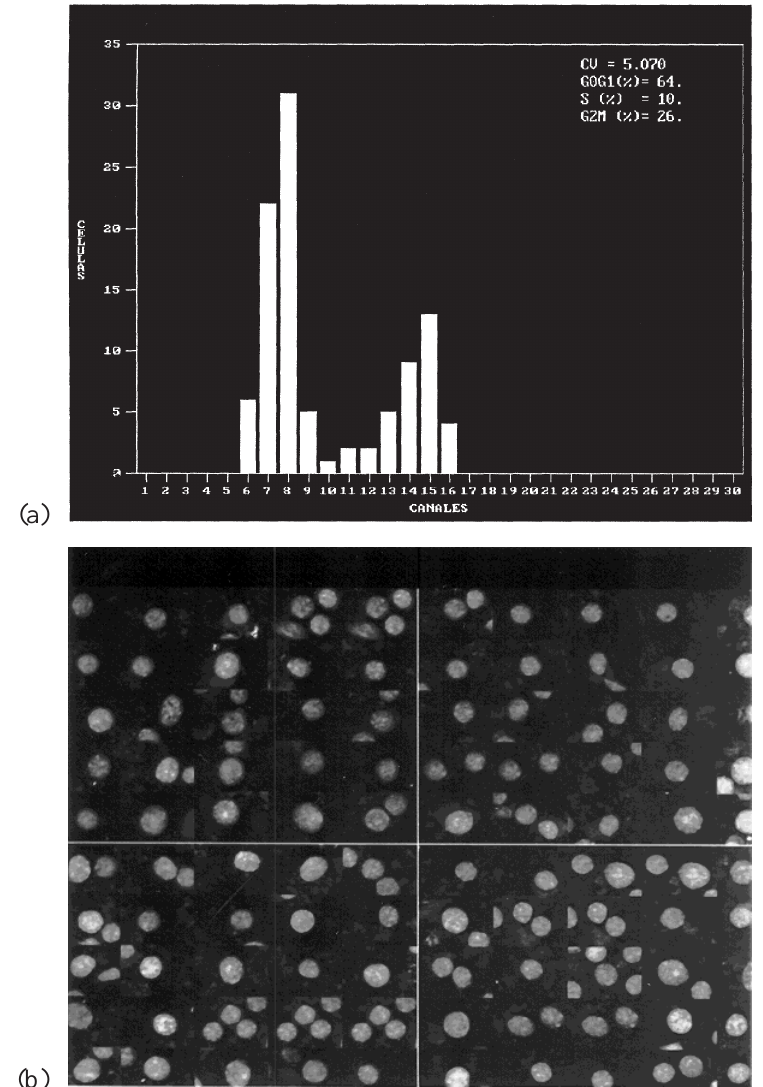
Fig. 2. Case no. 55 of a DHG with a balance translocation t(5,19) [29] showing a second polyploid clone in the static cytometry (a), also clearly detected in morphometric (b). Optical density image obtained with the Texcan software (cf. O. Ferrer-Roca and J. Martin, Informatics in pathology. Software developed by the Texcan Group, in: Advances in Analytical Cellular Pathology , G. Burger, M. Oberholzer and G.P. Vooijs, eds, International Congress Series, Vol. 911, Excepta Medica, Amsterdam, 1990, pp.